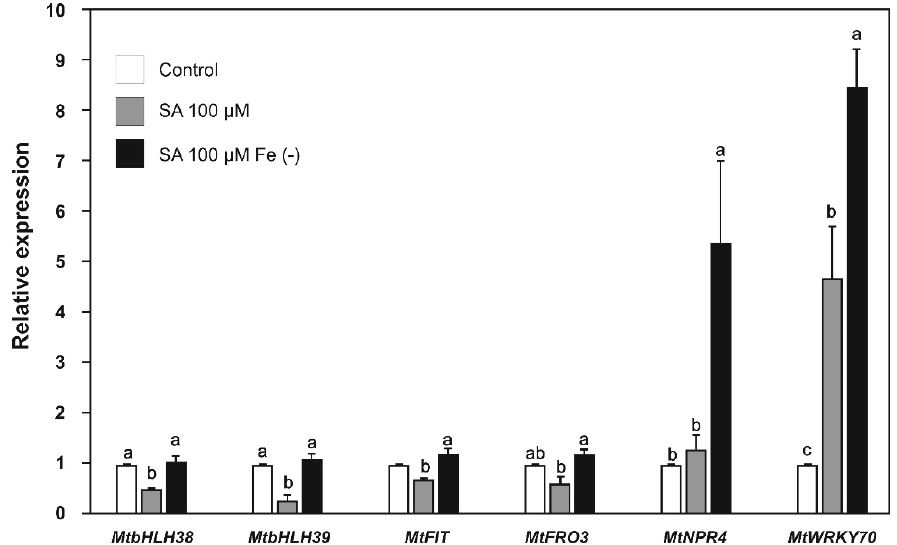
Figure 6. Relative expression of iron uptake and defense genes in Medicago truncatula plants grown with salicylic acid (100 μ M) under both iron-sufficient and iron-deficient conditions for 48 h. Values represent mean ± standard errors of relative expression in reference to controls. Different lowercase letters indicate significant differences as determined by one-way ANOVA and Tukey’s test ( p < 0.5; n = 3).